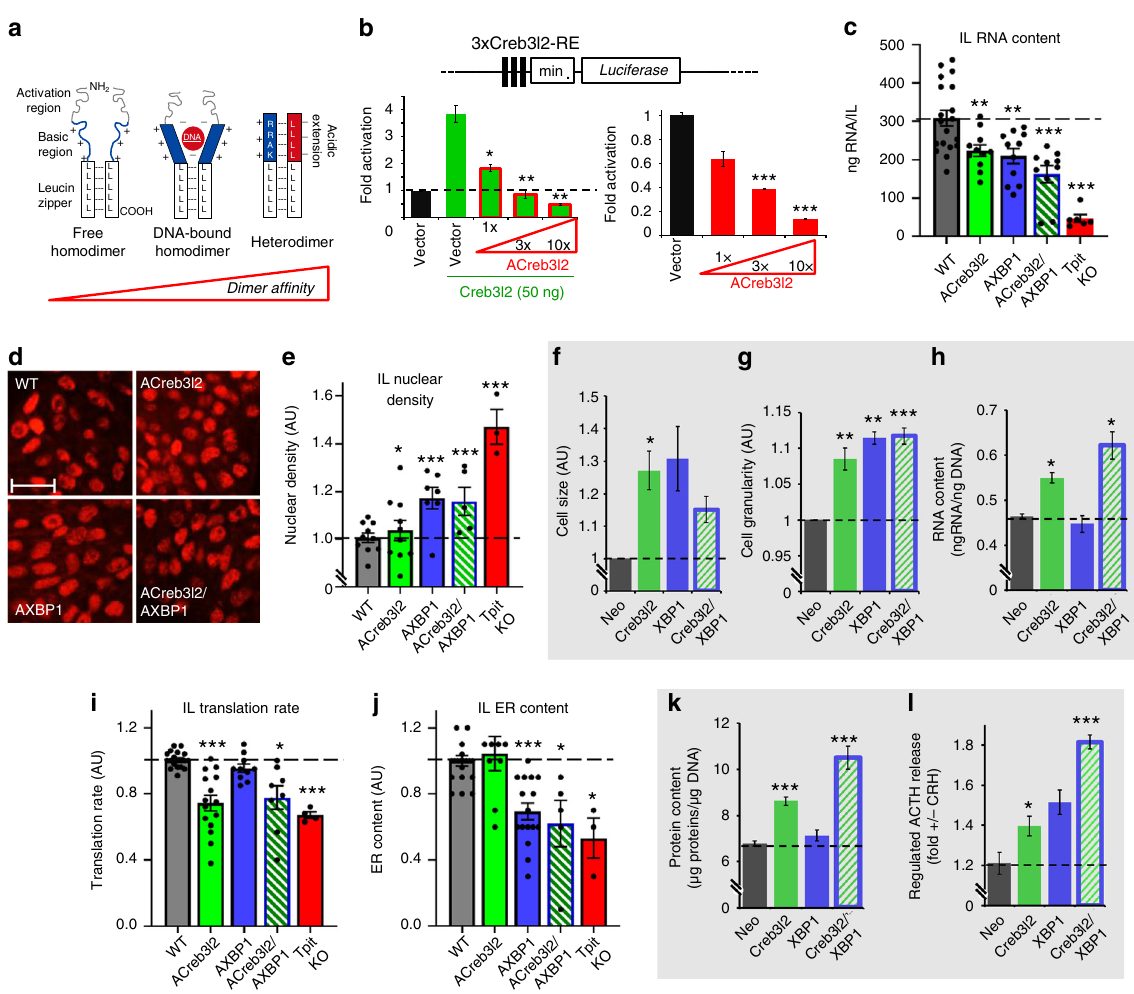
Fig. 3 Creb3l2 and XBP1 regulate different aspects of secretory capacity. a Schematic view of dominant negative inhibition of bZIP TFs by AZIP proteins (adapted from ref. 28 ). Left : free bZIP/bZIP homodimer with unstructured basic region (blue). Middle : DNA bound bZIP/bZIP homodimer with α -helical basic region. Right : bZIP/AZIP heterodimer where the basic region and the designed acidic amphipathic extension (red) interact as α -helices to extend the coiled-coil domain and prevent DNA binding. b Ef fi ciency of overexpressed ( left ) or endogenous ( right ) Creb3l2 inhibition by ACreb3l2. The Creb3l2-RE Luciferase reporter (3xCreb3l2-RE- luc ) was used to assess Creb3l2 activity and ACreb3l2 antagonism upon transfection into INS-1 cells; similar results were obtained in AtT-20 cells. c Total IL RNA contents measured in WT, ACreb3l2 , AXBP1 , ACreb3l2/AXBP1 transgenic, and Tpit-KO mice. Data are from 6 to 19 pools of 5 – 10 ILs. d , e Melanotrope nuclear density (Tpit nuclear staining: red) on histological sections of ILs from WT, ACreb3l2 , AXBP1 , and ACreb3l2/ AXBP1 transgenic mice d and their quanti fi cations in arbitrary units (AU) relative to WT melanotrope density adjusted to 1 e . f – h Creb3l2 and XBP1 gain of function in stably infected AtT-20 cells. FACS analyses showing cell size f and granularity g index for AtT-20 cells expressing Creb3l2, XBP1, or both compared to control neomycin-resistant (Neo) AtT-20 cells. Data (±SEM, n = 3) are presented relative to Neo cells set to 1. h Total RNA content of control AtT-20 cells (Neo) and AtT-20 cells expressing Creb3l2, XBP1 or both (±SEM, n = 3). i – l Relative contributions of Creb3l2 and XBP1 to secretory capacity. i SUnSET (puromycin incorporation) measurements of protein synthesis in IL cells of control (WT), ACreb3l2 , AXBP1 , ACreb3l2/AXBP1 transgenic, and Tpit- KO mice. Data in AU are presented as fractions of WT IL translation rates set to 1. j Melanotrope cell ER contents (ER-tracker) measured in WT, ACreb3l2 , AXBP1 , ACreb3l2/AXBP1 transgenic, and Tpit-KO mice. Data are presented as fraction of WT IL ER contents set to 1. k Total protein content of control AtT-20 cells (Neo) and AtT-20 cells expressing Creb3l2, XBP1, or both. l CRH-induced ACTH release from the indicated pools of AtT-20 cells. Each dot represents independent measure. Compared to controls using bilateral Student ’ s T -test with unequal variances: * P < 0.05, ** P < 0.005, *** P <